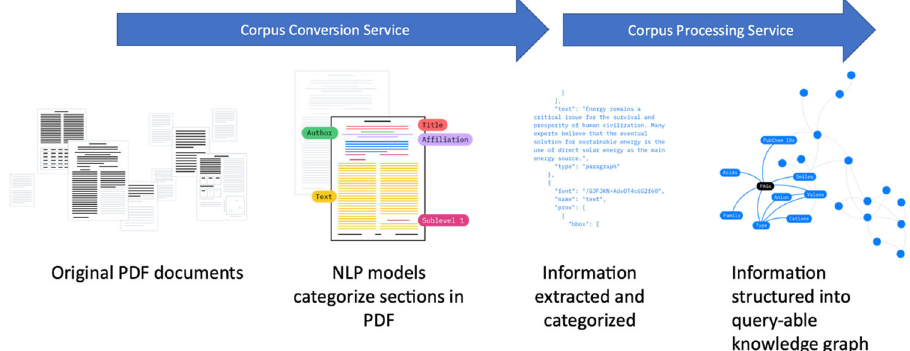
Fig. 3 IBM deep search. Knowledge generation from unstructured data (PDF) is achieved through the use of a platform called IBM DeepSearch, which consists of two systems; the Corpus Conversion Service (CCS) and Corpus Processing Service